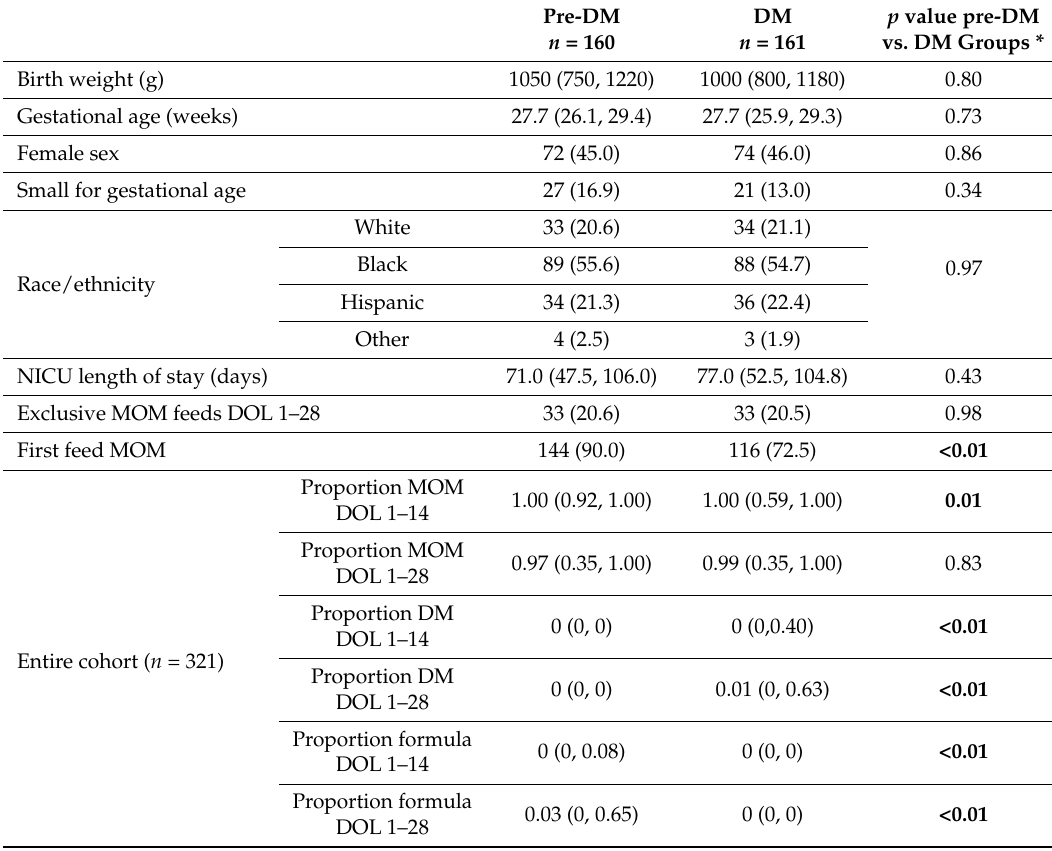
Table 1. Cohort characteristics: Median (IQR) or n